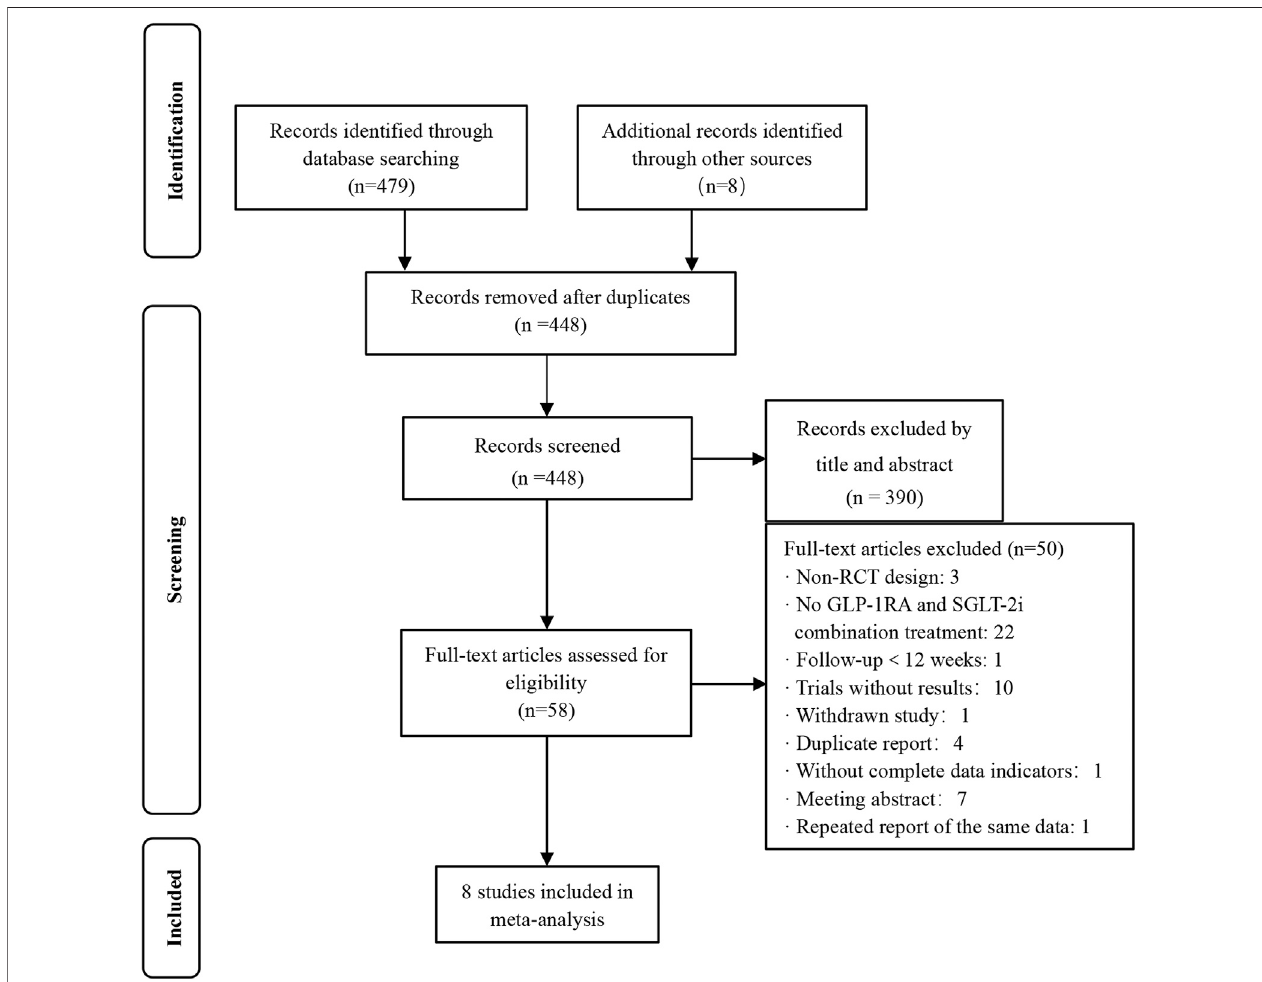
FIGURE 1 | Flow chart of the study selection. Non-RCT design: non-randomized controlled trial design.